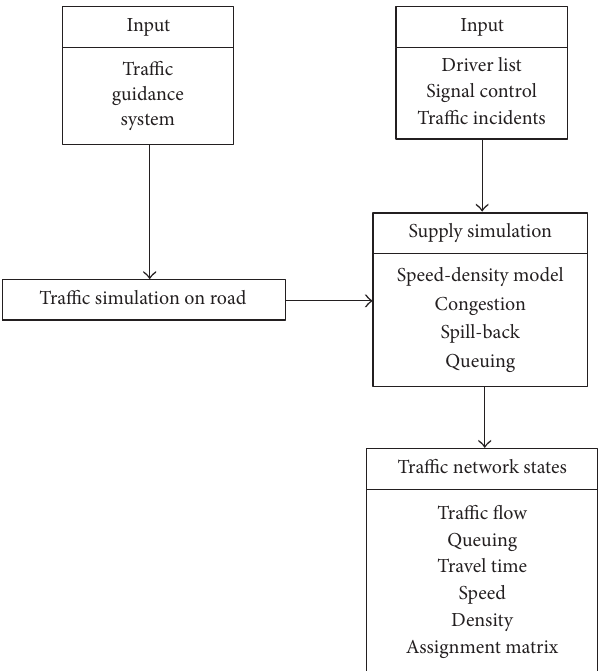
Figure 2: General process of